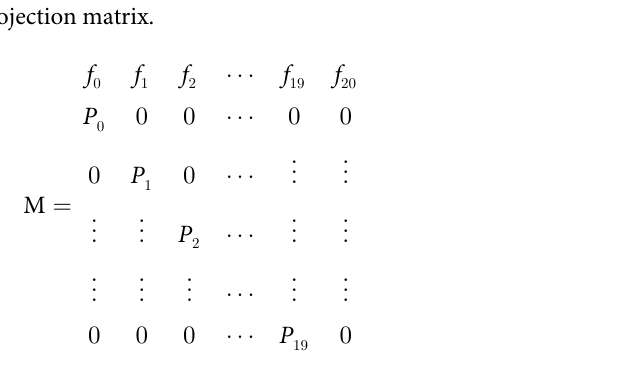
Then, the population massive and age structure after one unit time interval were deter- mined from the data of the previous time interval. N interval and N is the population quantity at the time of this survey. 0